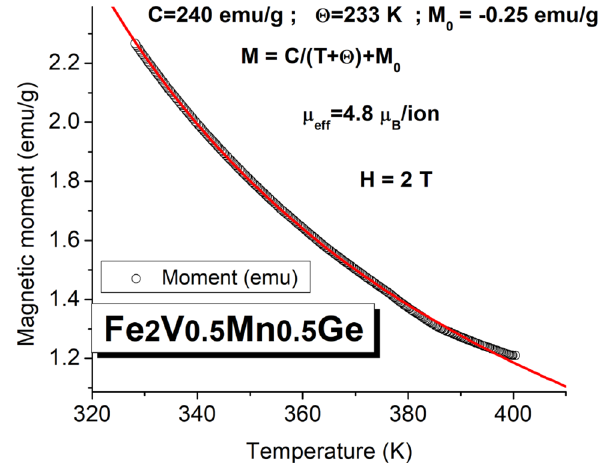
Fig. 9 The fitting of Fe and other